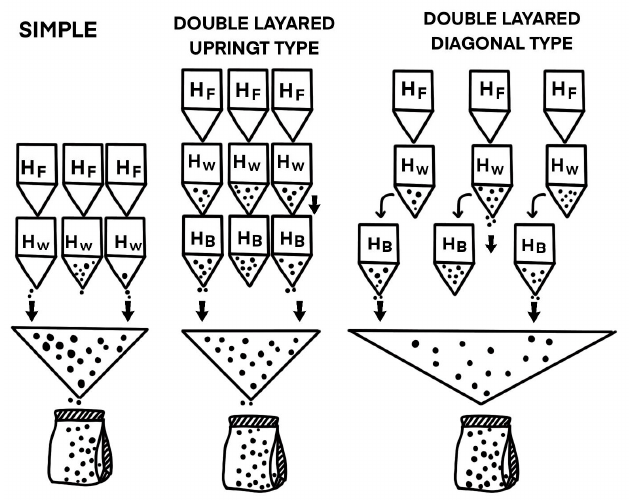
Figure 1. Weighing and discharge configuration on double-layered